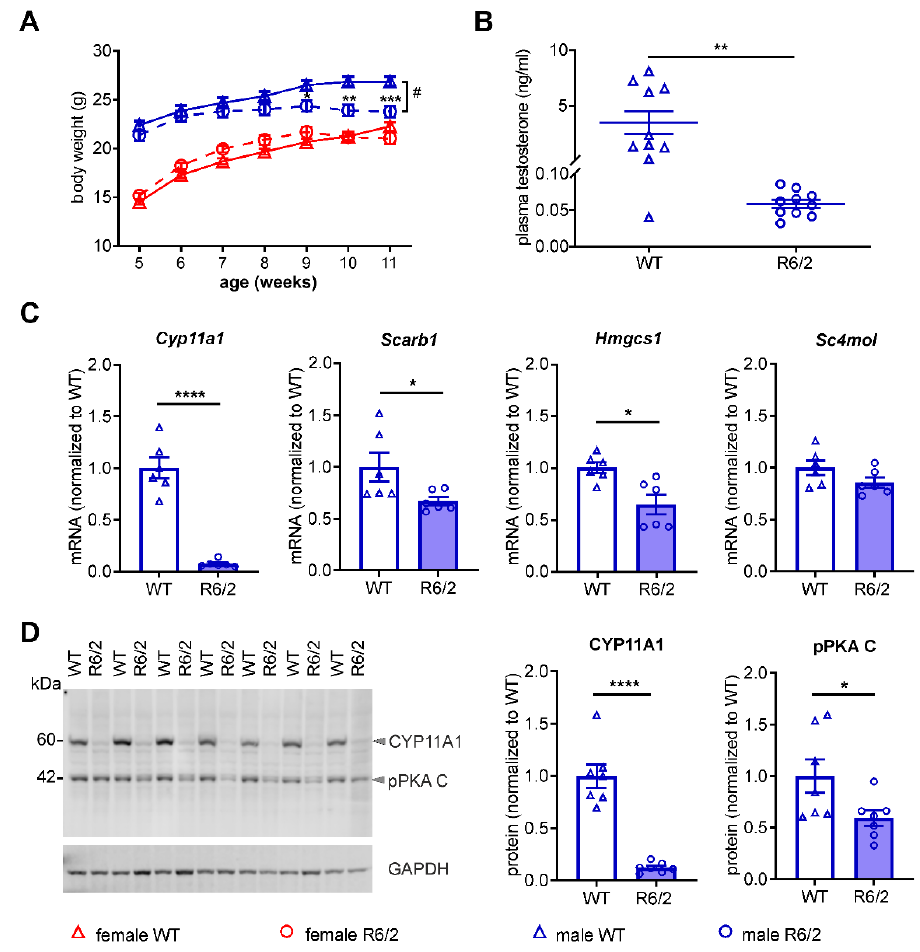
Figure 7. Altered body weight trajectory, plasma testosterone levels, testicular steroid biosynthesis- related gene expression and PKA activation in male R6/2 mice. ( A ) Longitudinal analysis of body weight in female and male WT and R6/2 mice from 5 to 11 weeks of age (females, n = 16/genotype; males, n = 11/genotype). ( B ) Plasma testosterone levels ( n = 11/genotype) in 11 weeks old male WT and R6/2 mice. ( C ) mRNA expression levels of steroid biosynthesis-related genes in the testes of male R6/2 mice and WT littermates at 11 weeks of age ( n = 6/genotype). ( D ) Western blot analysis of CYP11A1 and cAMP-activated catalytic subunit C of protein kinase A (pPKA C) in the testes of male R6/2 mice and WT littermates at 11 weeks of age ( n = 7/genotype). Statistical significance was deter- mined by two-way repeated measures ANOVA followed by Turkey post-hoc test in A and by Stu- dent’s t -test in B, C, and D. Data are expressed as individual values and mean ± SEM. * p ≤ 0.05; ** p ≤ 0.01; **** p ≤ 0.0001. 4. Discussion In this study, we showed sex differences in growth in both BACHD rats and R6/2 mice, which represent full-length and fragment animal models of HD, respectively. BW loss and muscle atrophy have been frequently reported in HD despite adequate nutrition. The underlying mechanisms can be partially explained by an altered energy balance [55]. However, the effect of sex differences in body weight change observed in HD patients and animals [6,12,13] as well as the sex-specific effects of the HTT gene on the brain volume development in children [57,58] indicate that there may be additional pathogenic mecha- nisms in the disease. In male BACHD rats, but not in female littermates, we found de- creased circulating levels of testosterone hormones that positively correlated with growth parameters and IGF-1 circulating levels. Interestingly, the decreased testosterone levels